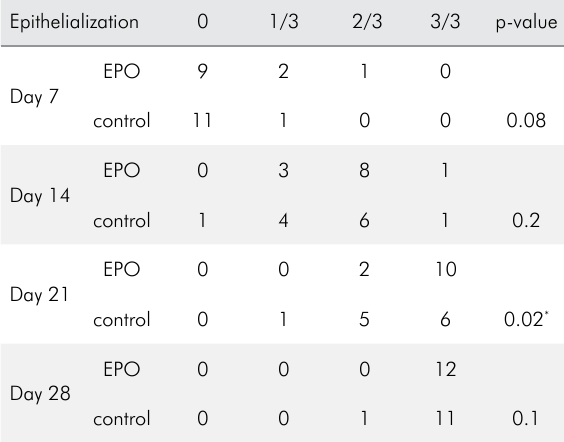
Table 1. Comparison of epithelialization rate.